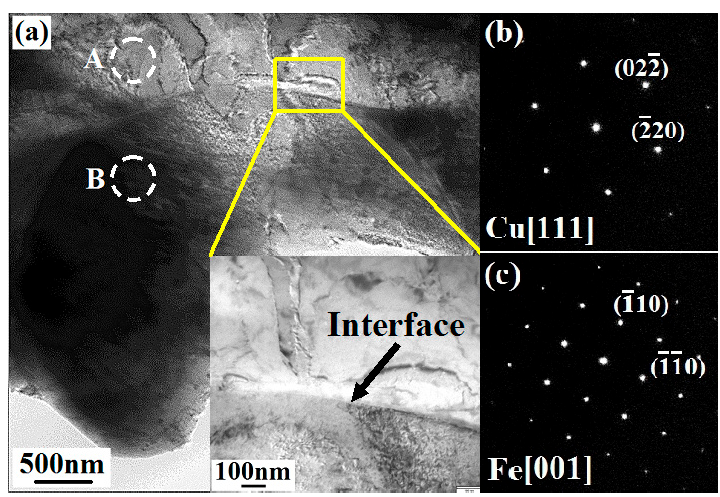
Figure 6 . ( a ) TEM images and selected area electron diffraction (SAED) patterns of ( b ) Cu matrix and ( c ) primary Fe phase.